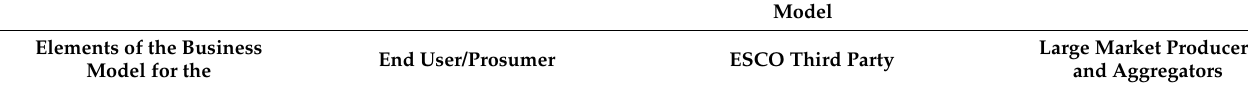
Table 1. Properties of changes that energy undertakings will undergo.